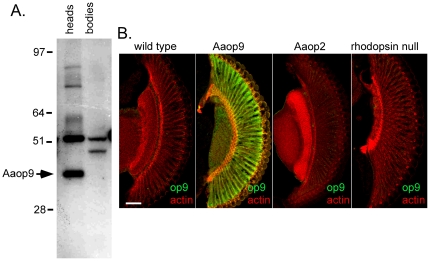
Specificity of Ae. aegypti Aaop9 antisera.A. Protein blot analysis shows the Ae. aegypti Aaop9 antiserum recognizes a 39 kD protein in Ae. aegypti heads but not bodies. Some higher molecular weight bands only detected in the head sample may identify Aaop9 rhodopsin multimers; a non-related crossreacting protein at 45–50 kD is found in both head and body samples. B. Immunofluorescent detection of Ae. aegypti Aaop9 expression in transgenic Drosophila shows Aaop9 expression in R1–6 photoreceptor cells (middle left panel) have strong retinal labeling, while minimal labeling is seen in retinal sections (other panels) of Drosophila expressing Rh1 rhodopsin (wild type), Ae. aegypti Aaop2 rhodopsin, or no rhodopsin (rhodopsin null). All flies were in a white eyed genetic background. The scale bar shown in panel at right is ∼50 µm.